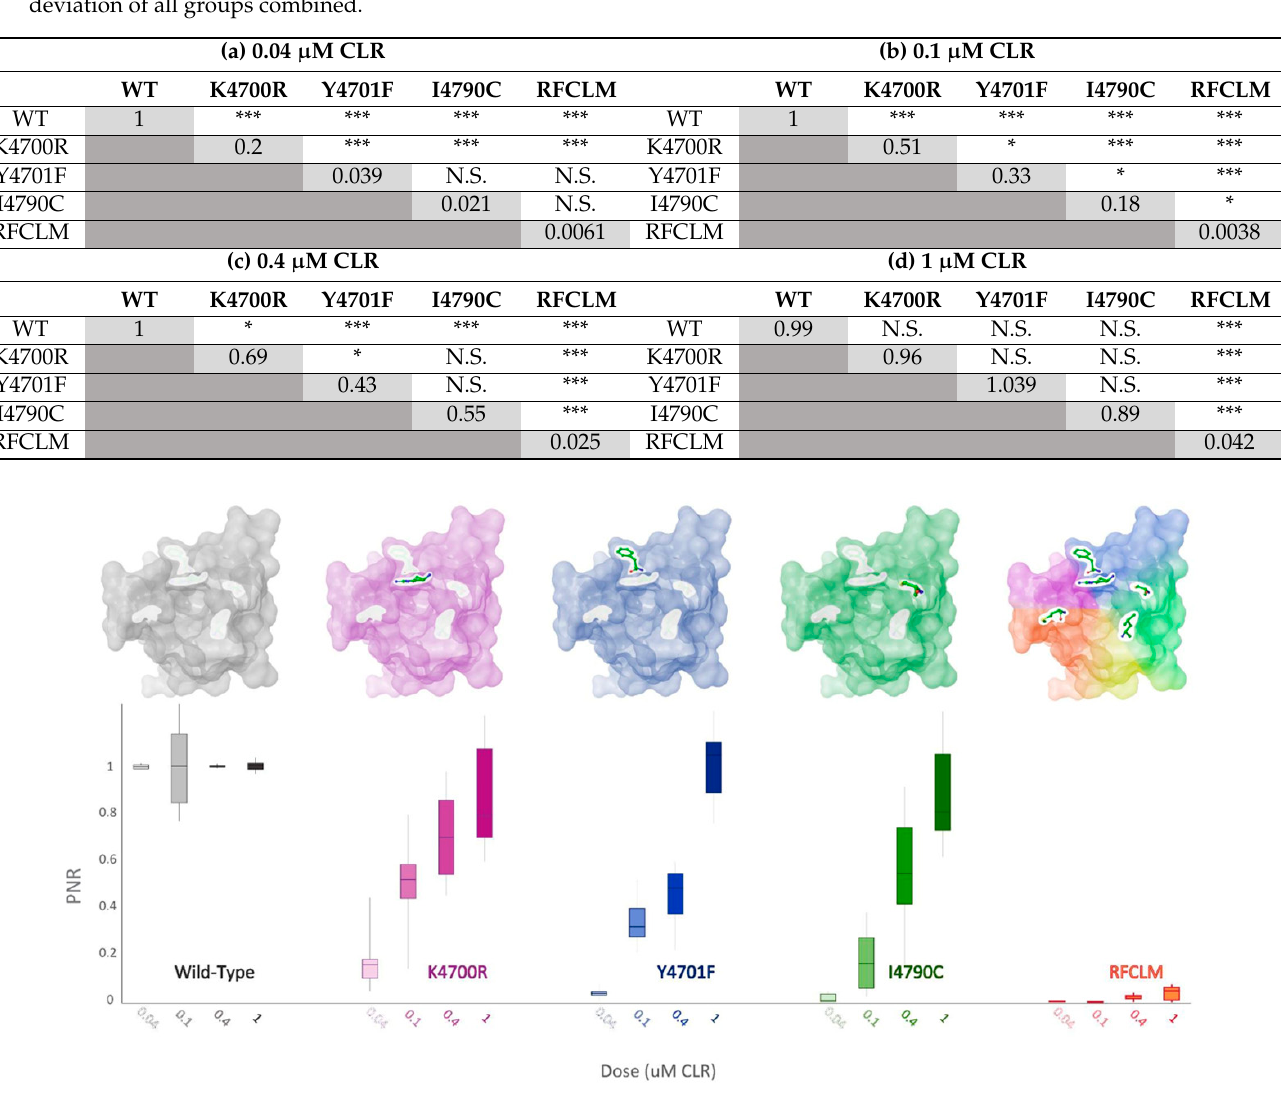
Figure 6. PxRyR variants exhibit differing responses to increasing concentrations of CLR. Sf9 cells (n = 5–26) expressing either Wild-Type (grey), K4700R (purple), Y4701F (blue), I4790C (green) or RFCLM (orange) -PxRyR were exposed to increasing concentrations of CLR. All diamide responses are expressed as proportional normalised responses (PNRs). Error bars represent SEM.